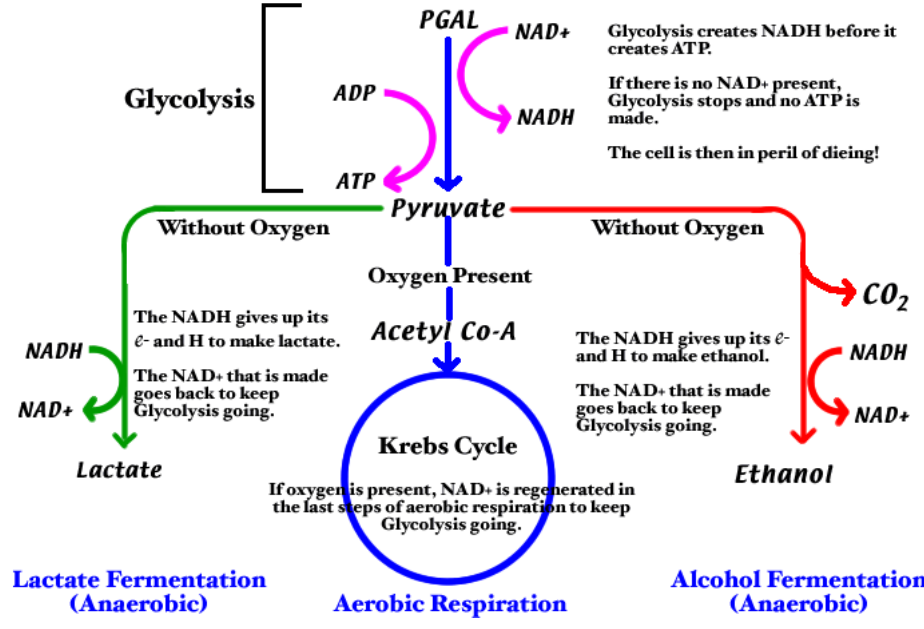
Figure 2. Lactate biochemical pathway. Legend: PGAL: 3-phosphoglyceraldehyde; ADP: Adenosine diphosphate; ATP: Adenosine triphosphate; NAD + : Nicotinamide adenine dinucleotide (oxidized form); NADH: Nicotinamide adenine dinucleotide (reduced form); CO 2 : carbon dioxide.